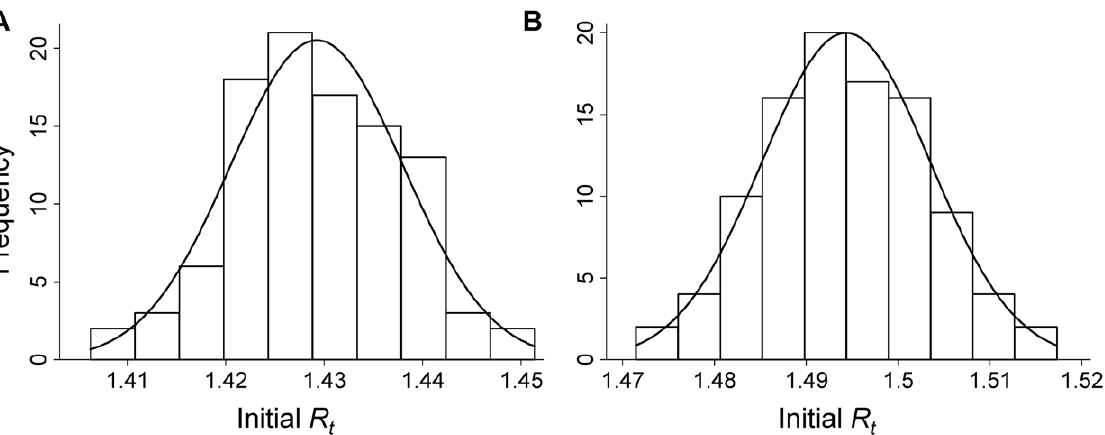
Figure 3. Distribution of the initial effective reproduction number ( R t ) across 100 simulations for the pandemic influenza A(H1N1)pdm09 epidemic in South Africa, assuming known serial interval (SI) estimates derived from (A) confirmed secondary cases only (SI: 2.3 days) and (B) confirmed plus suspected secondary cases (SI: 2.7 days) in the transmission chain (method 2).